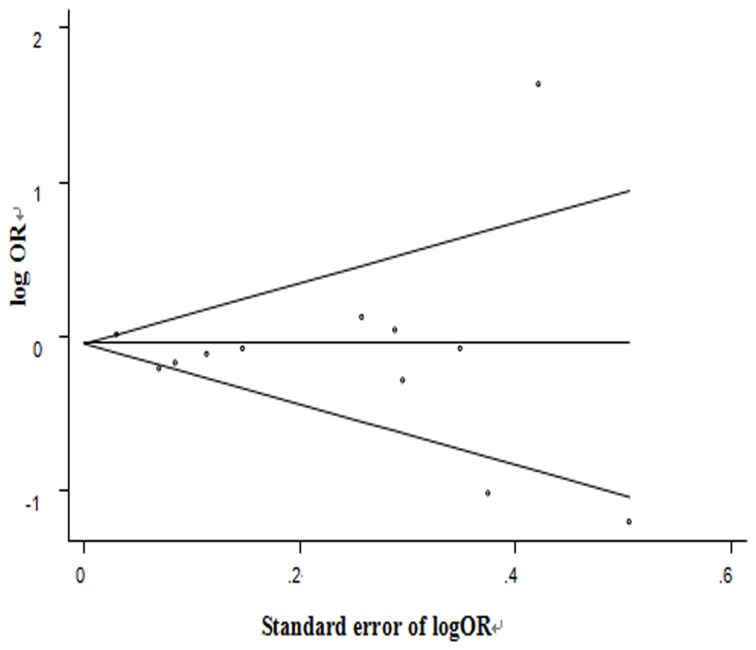
Begg’s funnel plot (with pseudo 95% confidence intervals) to detect any publication bias.